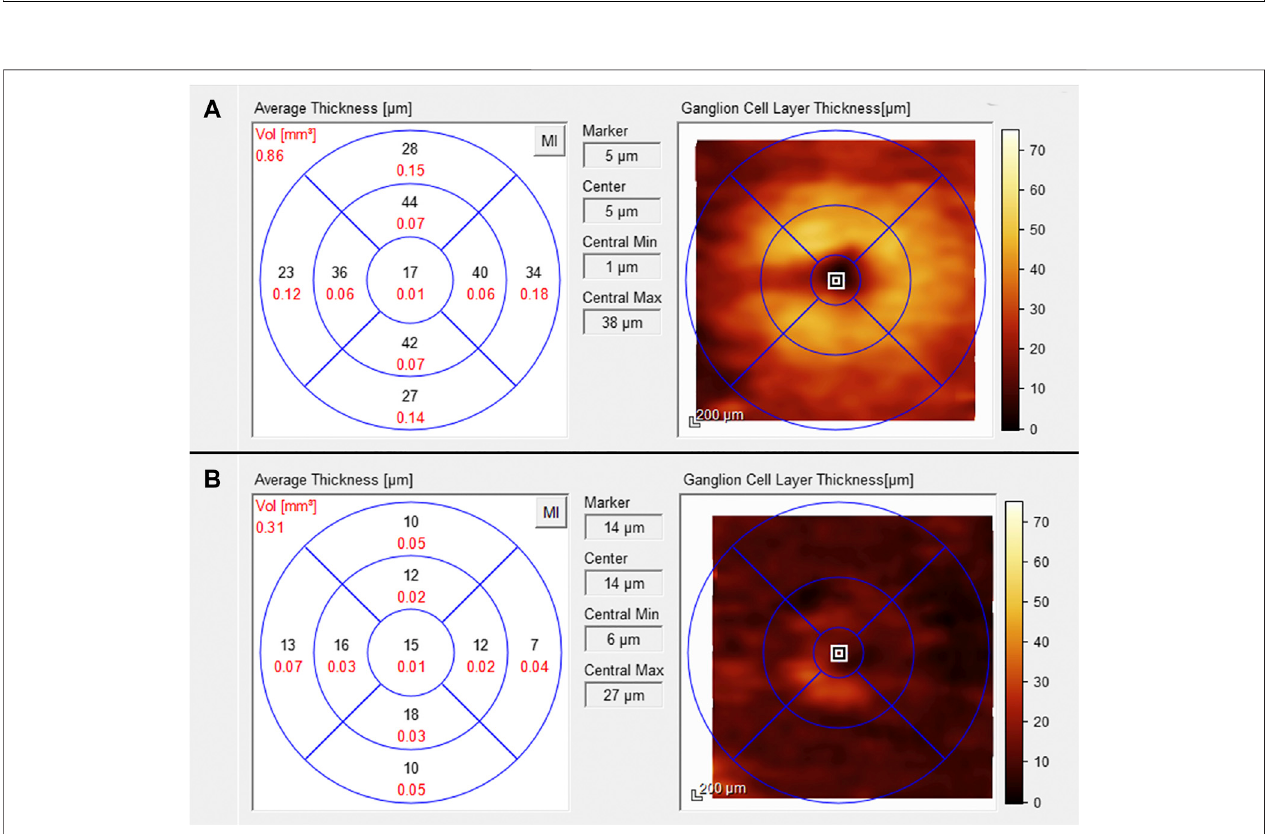
FIGURE 3 | Ganglion cell layer thickness analysis performed with the SD-OCT one month after the arterial occlusion. Within normal limits in the right eye (A) and atrophic in the left eye (B) [SD-OCT, spectral domain optical coherence tomography].